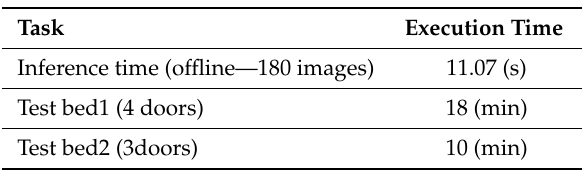
Table 2. Execution time analysis.